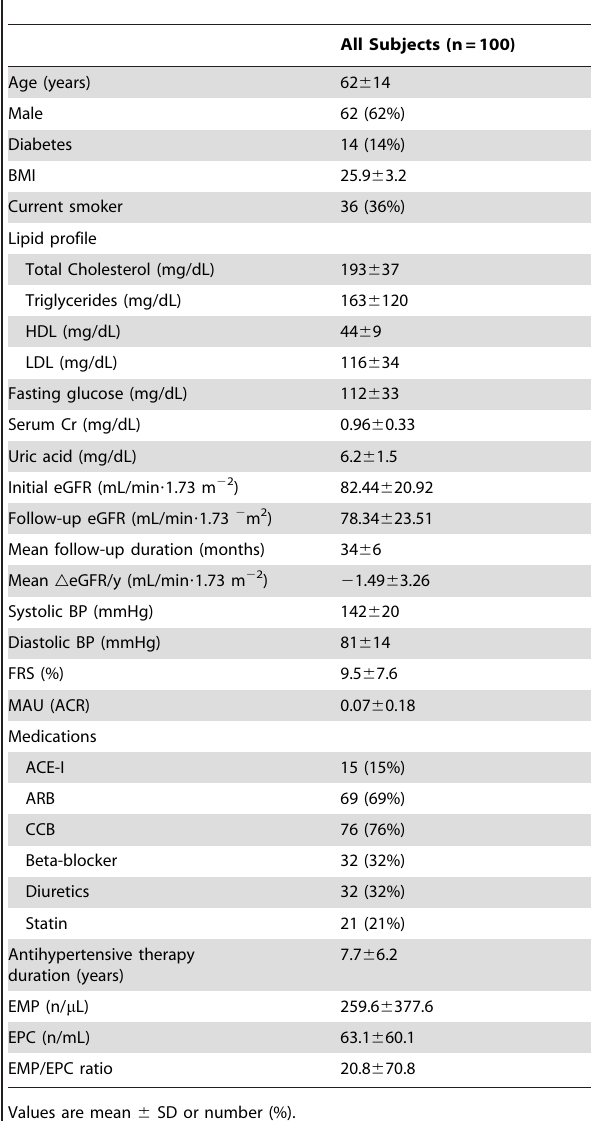
Table 1. Baseline characteristics of study